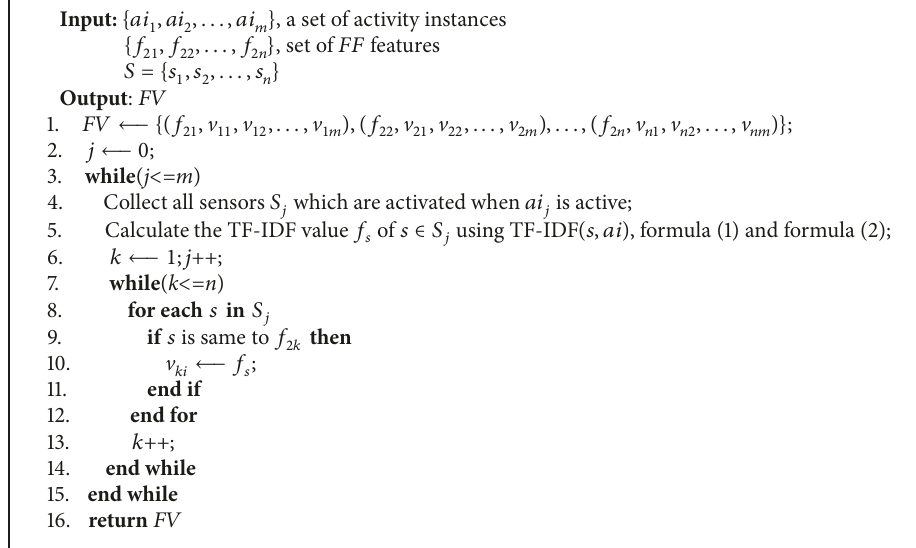
Algorithm 2: solveTF-IDFFeature .